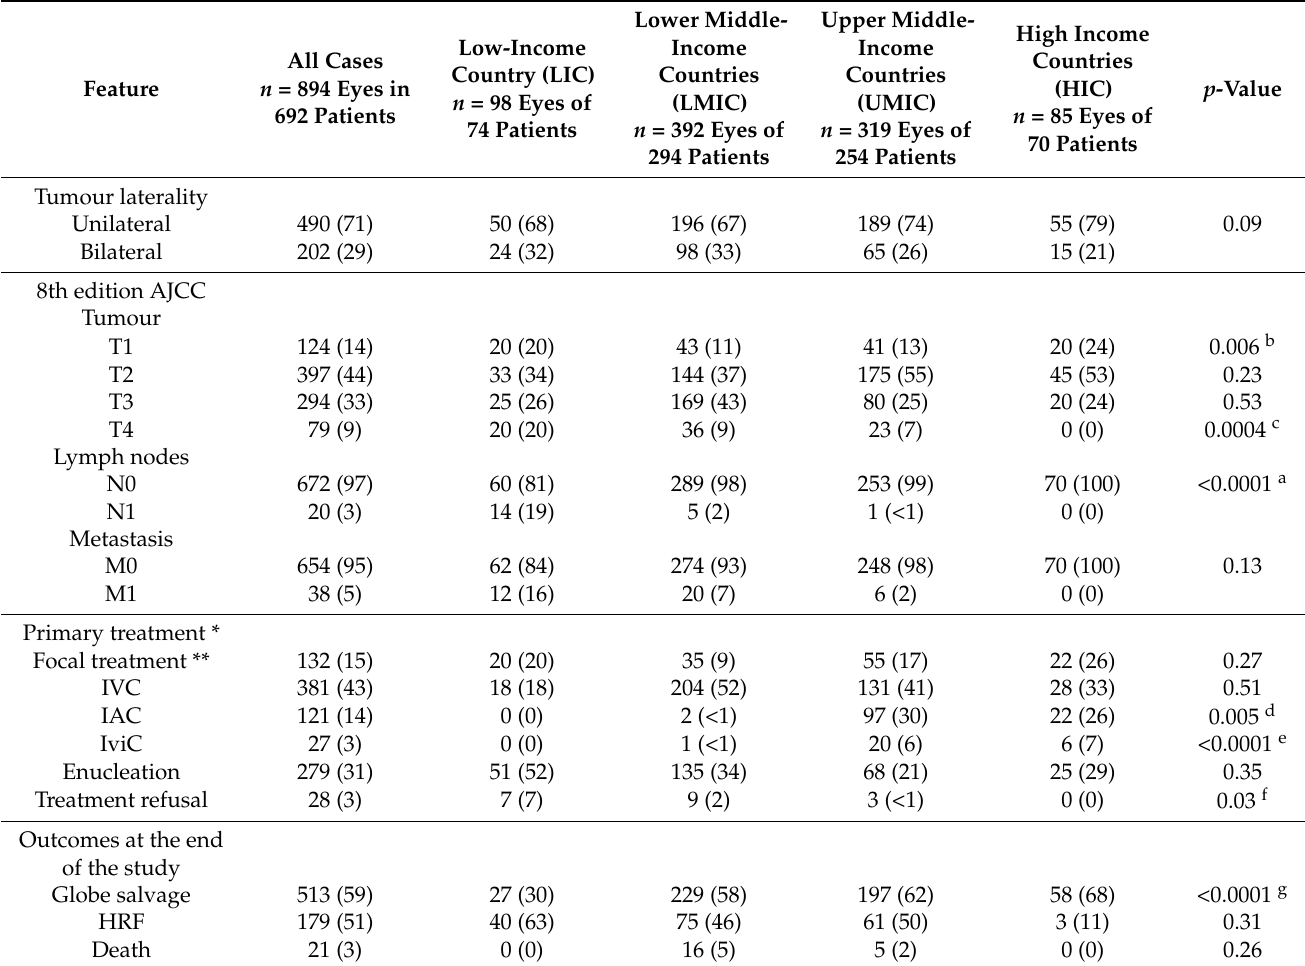
Table 2. Clinical features, treatment and outcomes of 692 retinoblastoma patients from 10 countries.